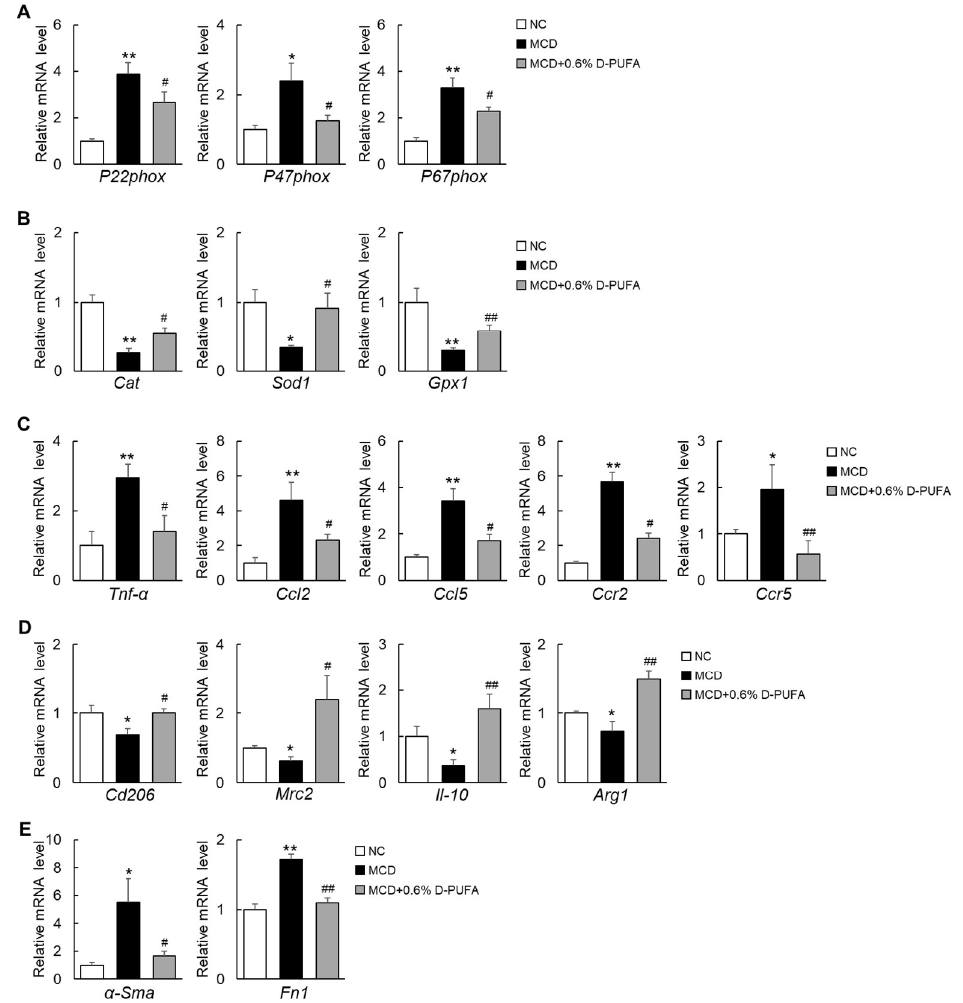
Figure 4. D-PUFAs decrease oxidative stress and inflammation in the liver of NASH mice. ( A ) mRNA expression of oxidative-stress-related genes in the liver. ( B ) mRNA expression of antioxidative-stress-related genes in the liver. ( C ) mRNA expression of inflammation genes in the liver. ( D ) mRNA expression of anti-inflammation genes in the liver. ( E ) mRNA expression of fibrosis genes in the liver. Data are presented as means ± SEM, n = 5–6. * p < 0.05, ** p < 0.01 NC; # p < 0.05, ## p < 0.01 vs.